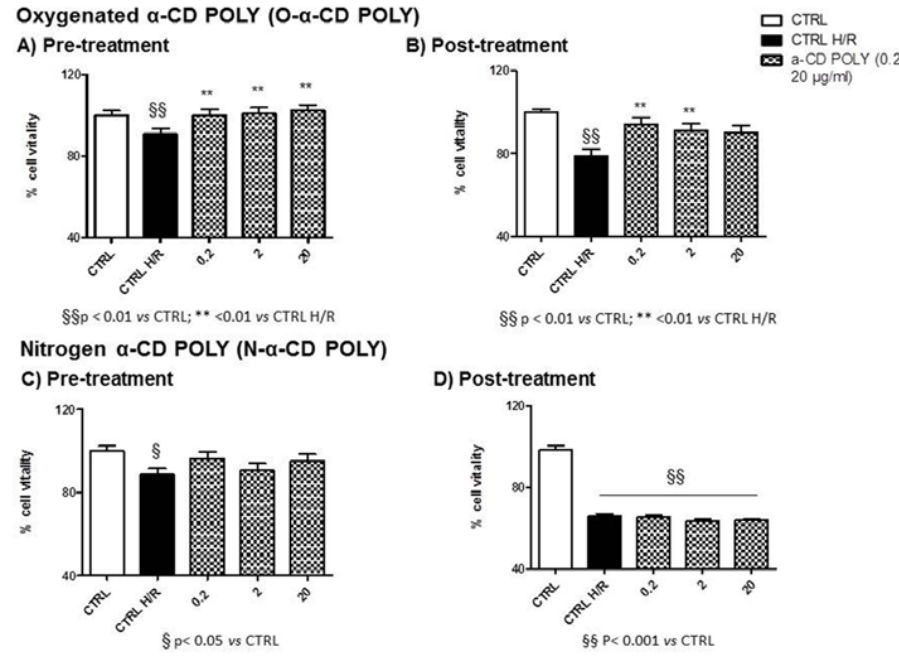
Figure 7. Cell vitality of α-CD POLY treated H9c2 cells and H/R conditions. ( A ) Pre-treatment with O-α-CD POLY (0.2, 2, and 20 µg/mL); ( B ) Post-treatment with O-α-CD POLY (0.2, 2, and 20 µg/mL); ( C ) Pre-treatment with N-α-CD POLY (0.2, 2, and 20 µg/mL); ( D ) Post-treatment with O-α-CD POLY (0.2, 2, and 20 µg/mL) compared to the untreated control group (CTRL) and the hypoxia–reoxygenation group (CTRL H/R). Data were normalized to mean value in control conditions and expressed as a percentage.